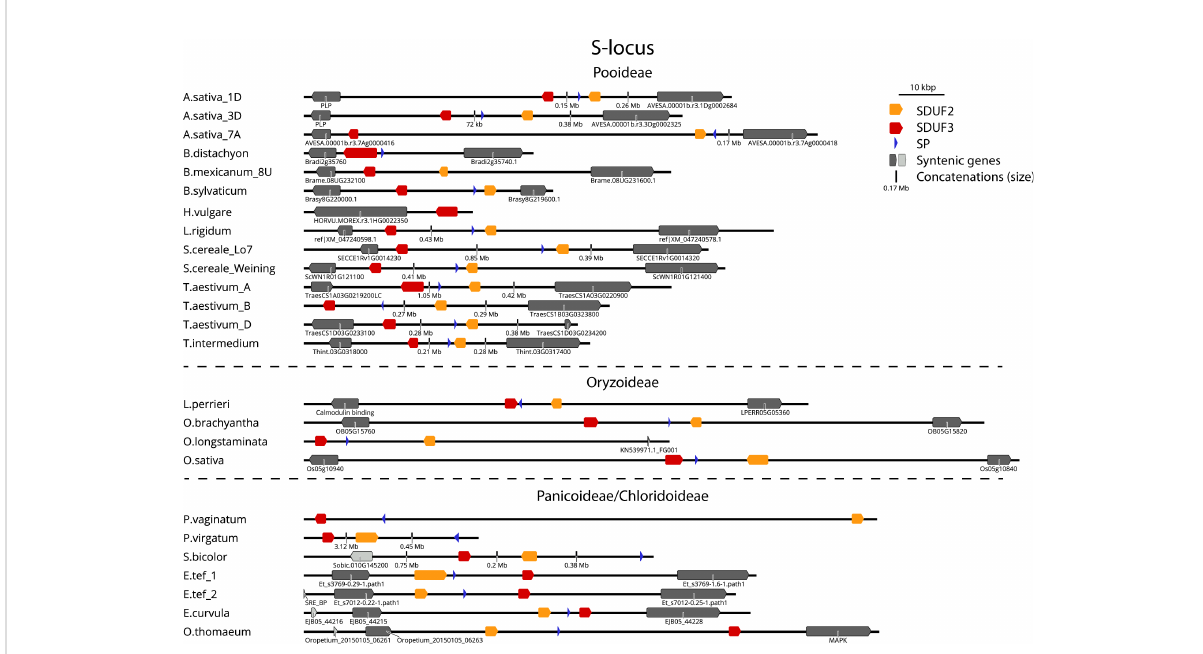
a gene encoding a calmodulin binding protein (left) and a zinc permease (right). Chloridoideae grasses (bottom) are fl anked by a Sterol- response element binding protein (SRE-BP; left, light grey) and Flavin reductase (left, dark grey) and a Mitogen activated protein kinase (MAPK, right). Panicoideae grasses ( S. bicolor, P. virgatum, P. vaginatum ) did not show obvious synteny, except for SRE-BP in S. bicolor . Gene identi fi ers of fl anking genes are shown where available. See Supplementary Dataset S4 for details of